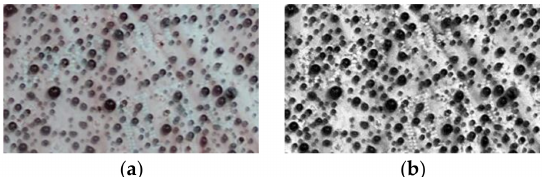
Figure 1. Enhancement of images by gray-scale processing and adaptive histogram equalization. ( a ) Original image; and, ( b ) enhanced